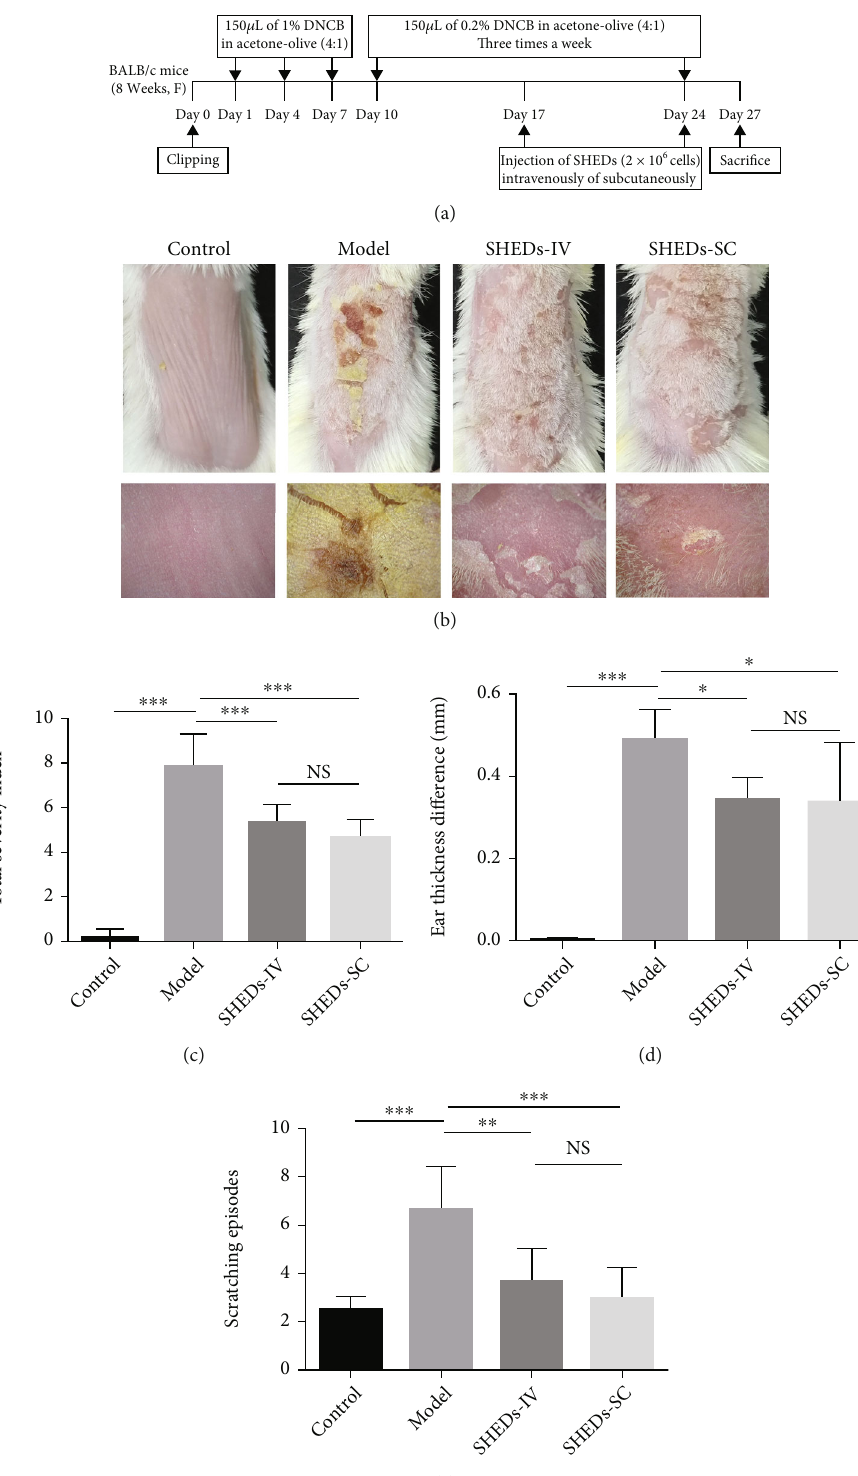
Figure 1: Experimental procedure and e ff ect of SHEDs on the clinical features of AD-like symptoms induced by DNCB in BALB/c mice at the time of sacri fi ce. (a) Schematic diagram of the experimental procedure for the induction of AD lesions and SHED administration. (b) Cutaneous manifestations in mice in each group. (c) Clinical skin severity scores of AD-like skin lesions in BALB/c mice of each group. The total score is the sum of individual scores determined based on the symptoms of erythema/haemorrhage, scarring/dryness, edema, and excoriation/erosion. (d) Ear thickness di ff erence in BALB/c mice of each group. (e) Scratching behaviour di ff erence in BALB/c mice of each group. All the data are expressed as mean ± SD ( n = 6 ). Three repeated times of each experiment were